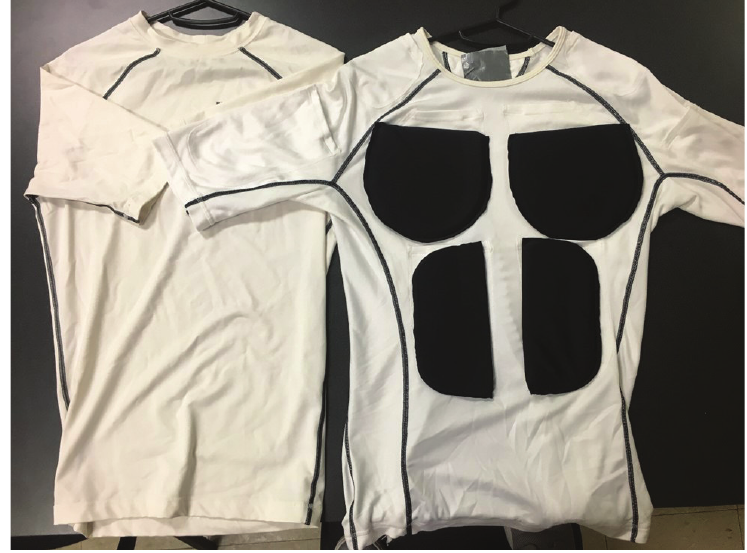
FIGURE 1. Visual representation of the weighted compression garment inner and outer shirts plus inserts. With all pockets loaded with two inserts, the final mass of the weighted compression garment was 6.8